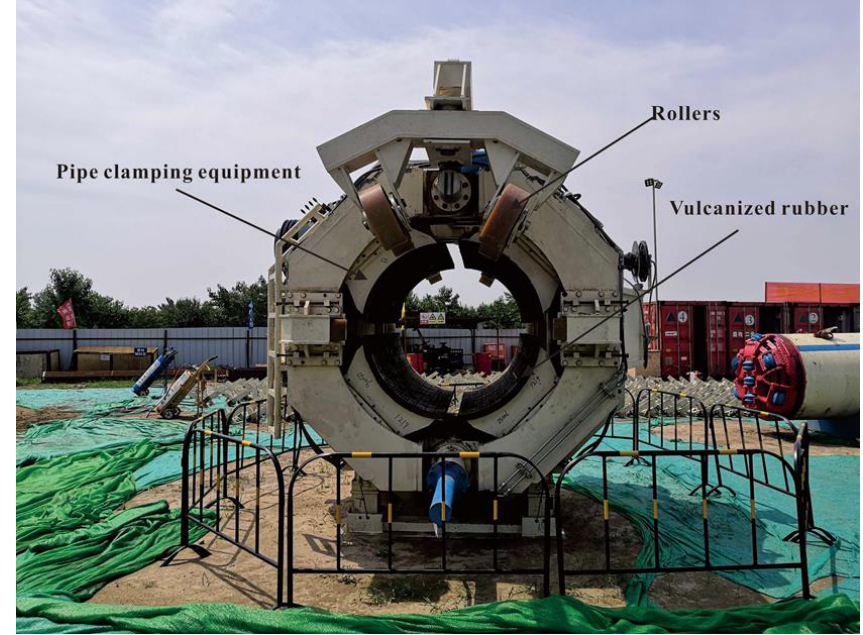
Figure 6. The thrust machine of the rapid laying and jacking machine.